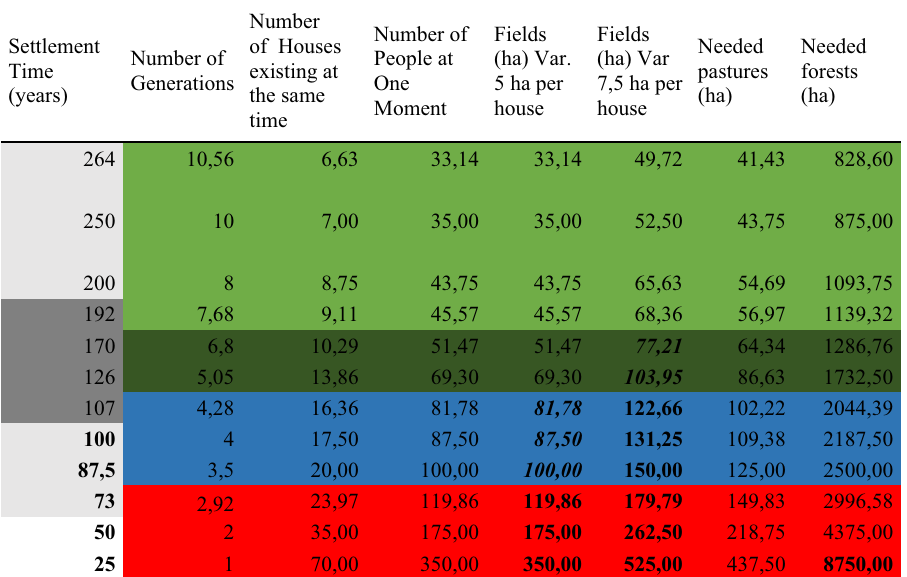
Table 2. Březnice: possible duration of the settlement based on four land use strategies: light green-optimal extent of the fields (69 hectares), with 7.5 hectares of fields per homestead; dark green-maximal extent of the fields (104 ha) or more intensive use of the fields (5 ha/homestead); maximal use and maximal extent; red—not sustainable agriculture or location of fields on places outside predicted optimal areas. For comparison dark grey show 95% significance for 14 C dating and light grey show 68%